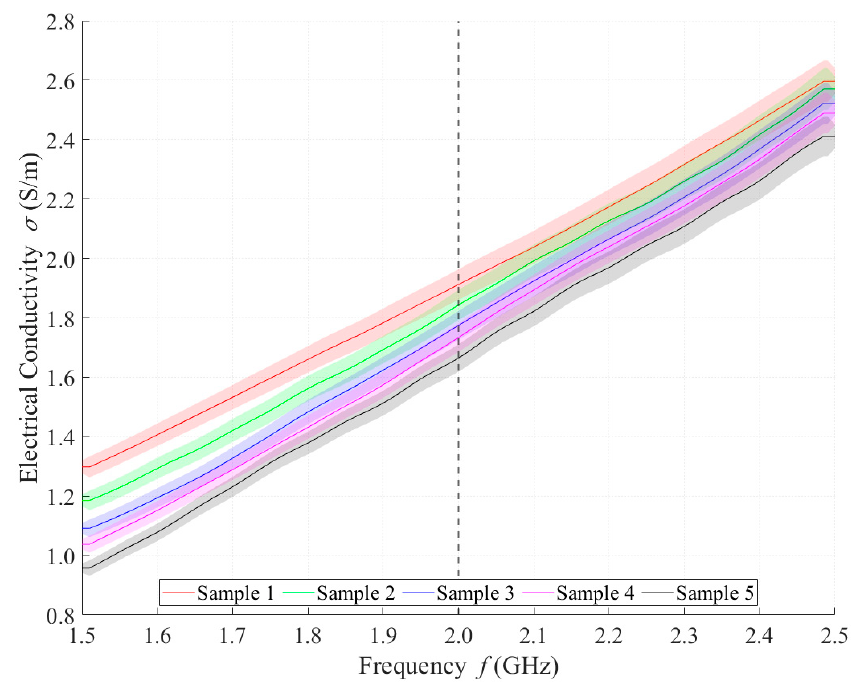
Figure 4. Measured values of relative permittivity.